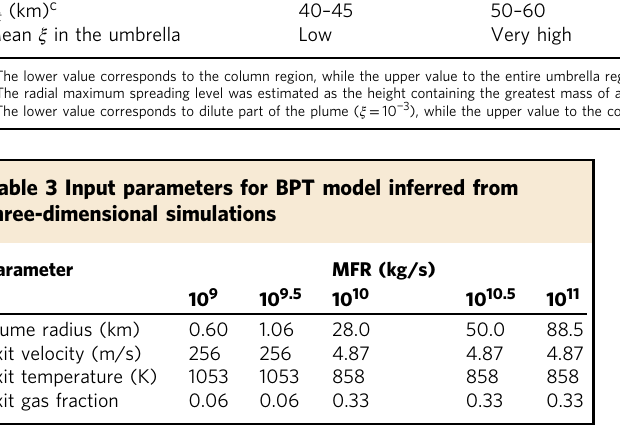
Table 2 Typical plume heights for different MFRs Plume dynamics